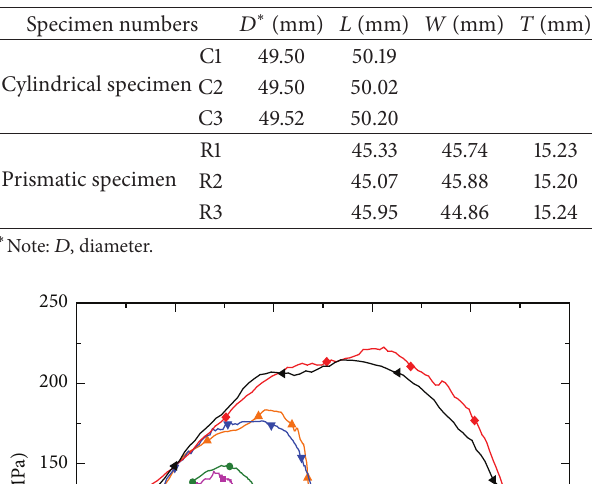
Table 4: The dimensions of marble specimens with different cross- sectional shapes.